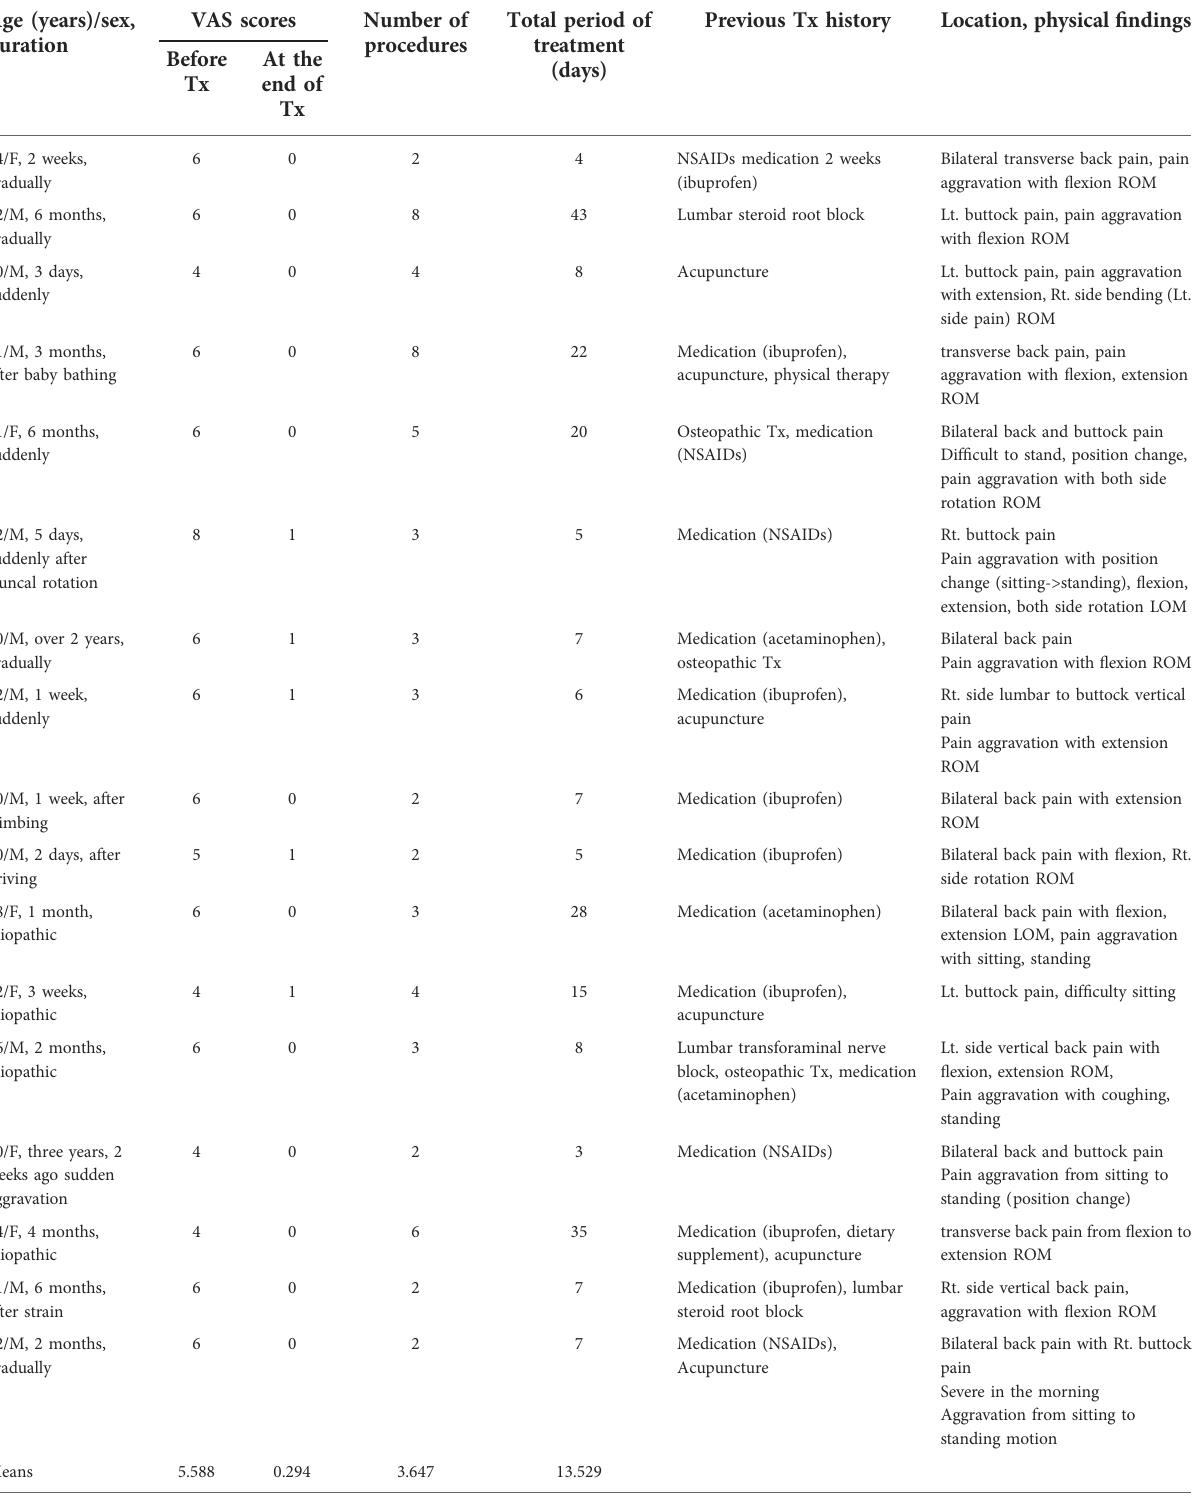
TABLE 1 Demographic data of patients, visual analog scale scores, and clinical fi